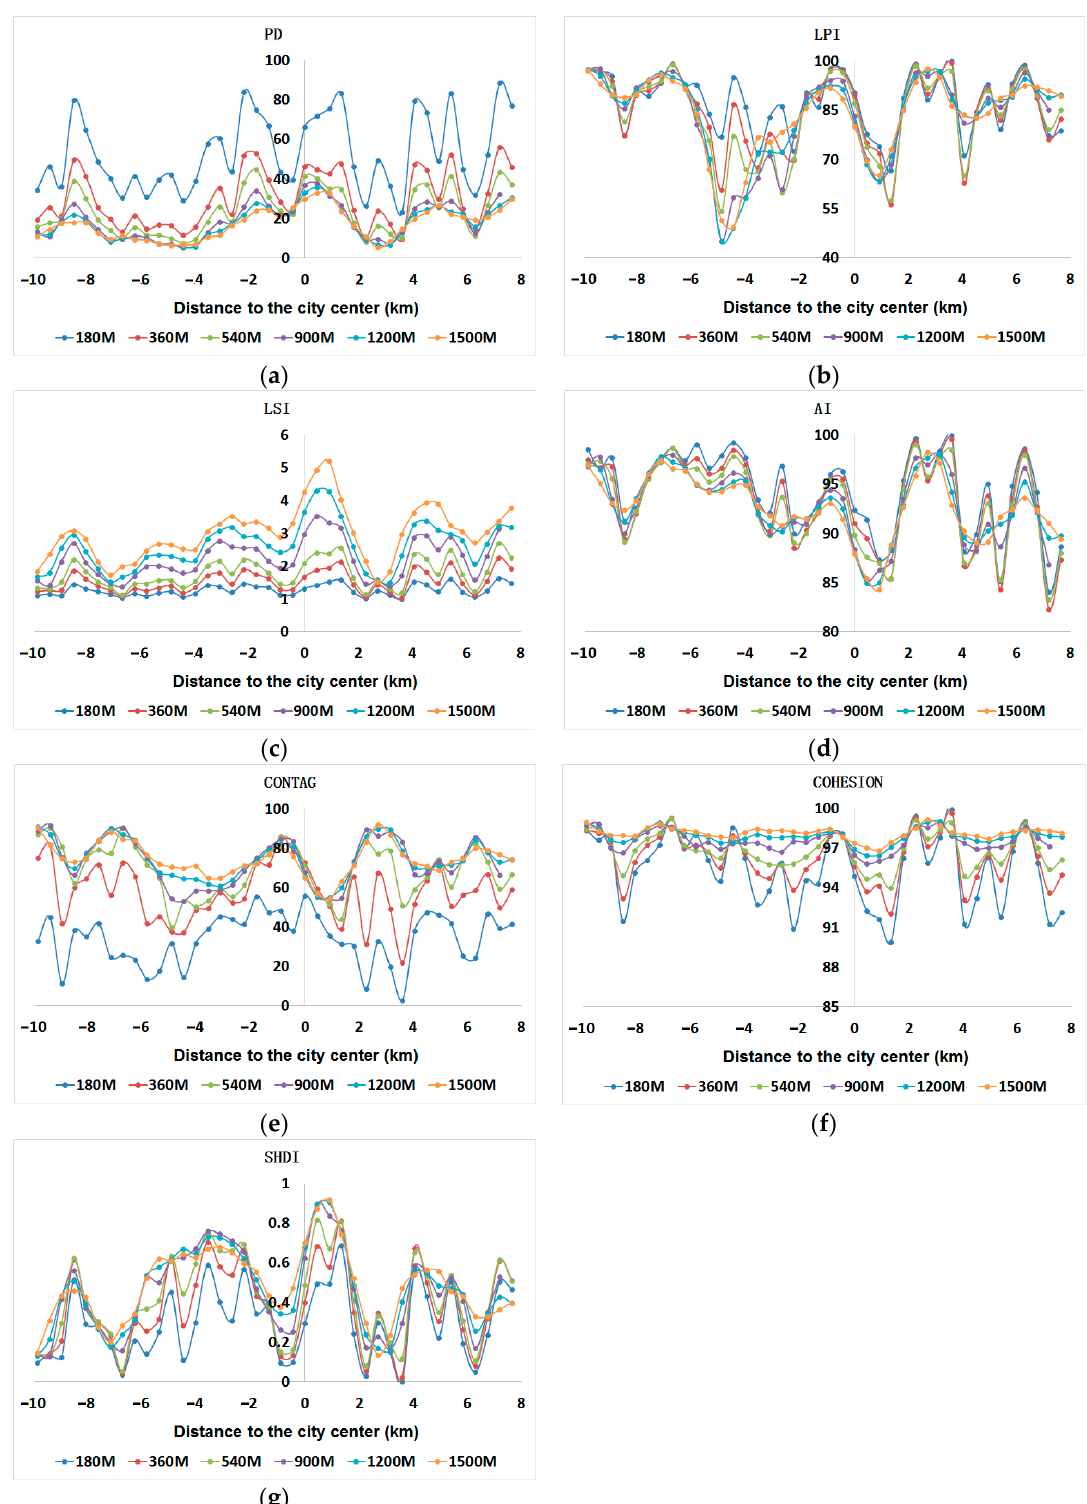
Figure 3. Curves of landscape metrics under different window sizes: ( a ) PD; ( b ) LPI; ( c ) LSI; ( d ) AI; ( e ) CONTAG; ( f ) COHE- SION; ( g ) SHDI. (Note: PD = Patch Density, LPI = Largest Patch Index, LSI = Landscape Shape Index, AI = Aggregation Index, CONTAG = Contagion Index, COHESION = Patch Cohesion Index, SHDI = Shannon’s Diversity